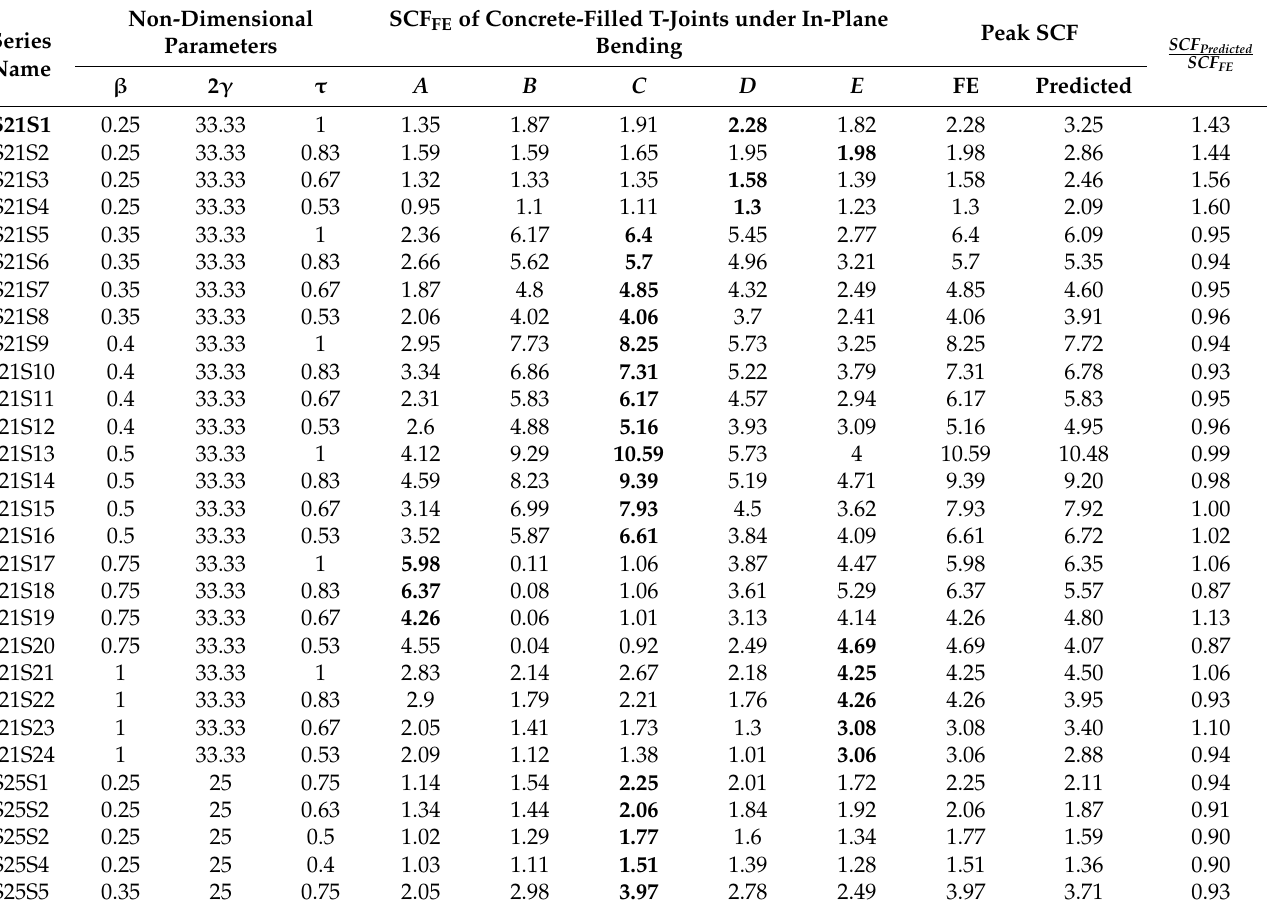
Table 15. Peak SCFs from predicted design equation with